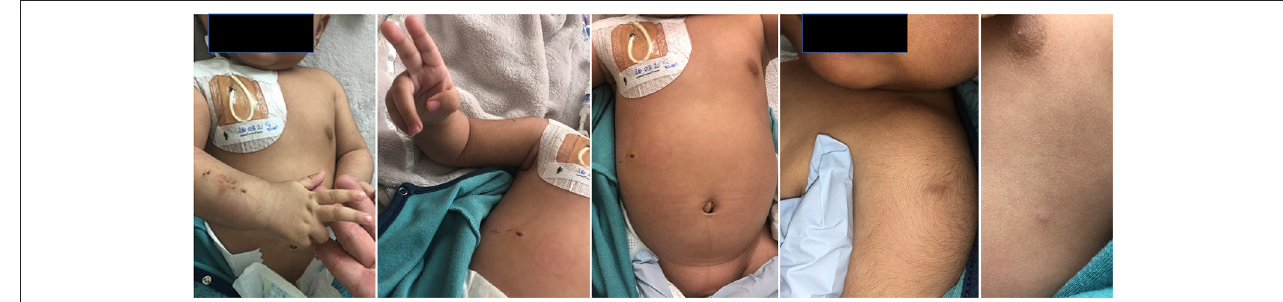
FIGURE 1 | The swelling near the right wrist with the inability to move the right little and ring figures are shown. The abdominal distension (massive hepatosplenomegaly), the BCG site and a subcutaneous nodule are also evident.